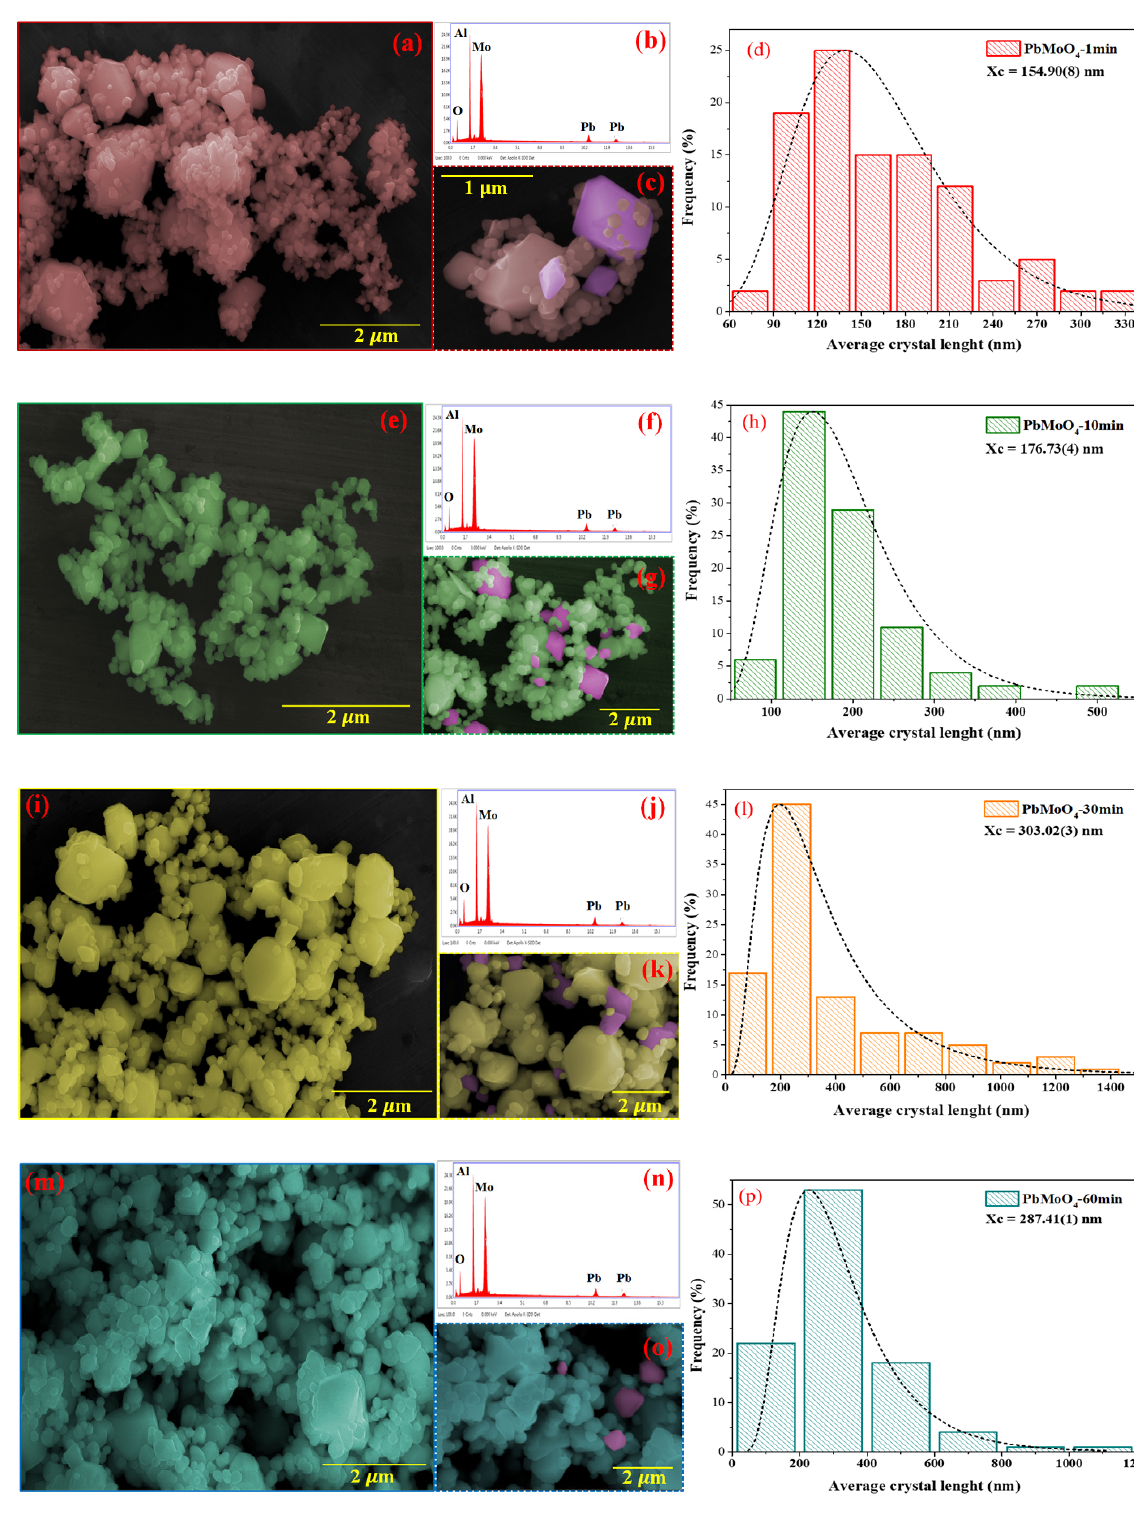
Figure 6. FE-SEM and EDX of PbMoO 4 nanocrystals synthesized at 1 min ( a – c ), 10 min ( e – g ), 30 min ( i – k ) and 60 min ( m – o ). The figures ( d , h , l , p ) correspond to the histogram of the particle size of PbMoO 4 .